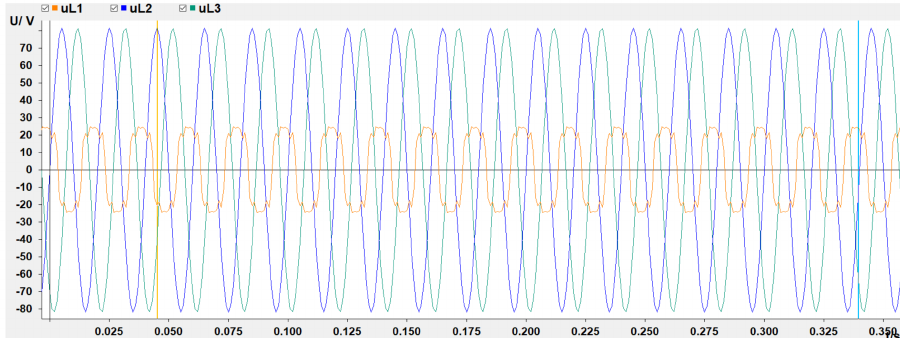
Figure 11. Voltage waveforms during single-phase fault